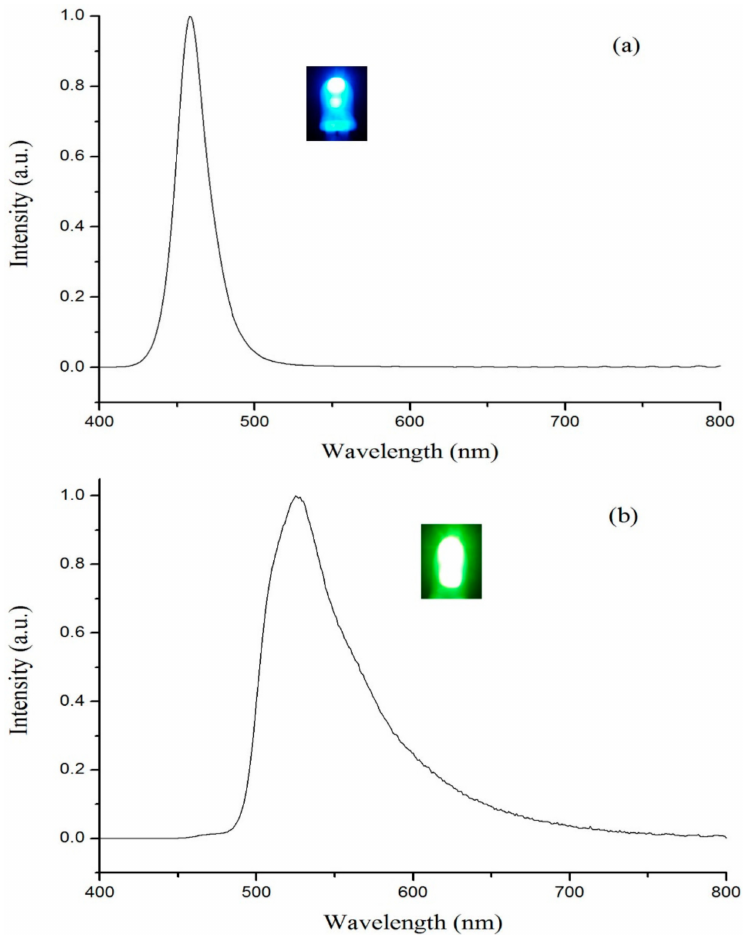
Figure 5. Emission spectra of the original ~460 nm-emitting InGaN LED without phosphor ( a ) and the LED with BPEA as phosphors ( b ) under excitation of 20 mA forward bias (insert: Photographs of the lighting LEDs).